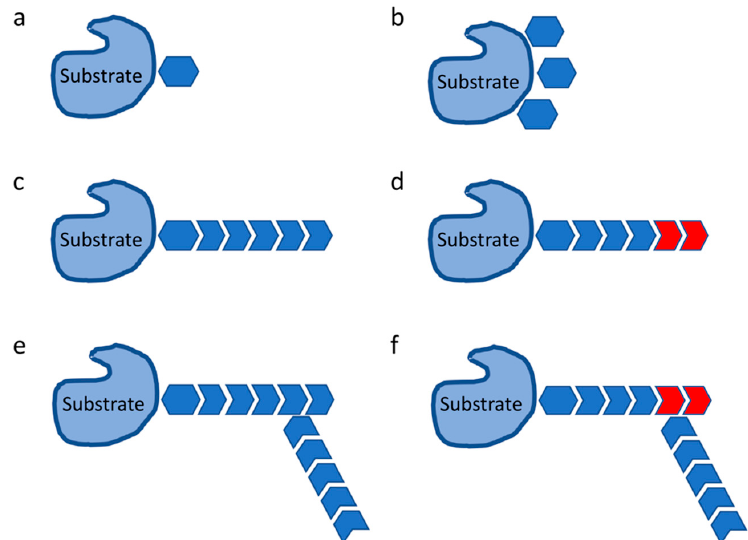
Figure 2. Ubiquitylation signals. Depending on the intracellular pathway the substrate proteins are part of/involved into, as well as on their final outcome (i.e., protein degradation and turn-over vs. change in localization, differential interaction, etc.), several types of ubiquitylation signals can be generated, such as mono-ubiquitylation signals, bearing (on the substrate protein) either a single ( a ) or multiple ( b ) ubiquitin monomers. Poly-ubiquitylation signals can determine more complex moieties, leading to homotypic ( c ), mixed ( d ), branched ( e ), or branched and mixed chains ( f ) of